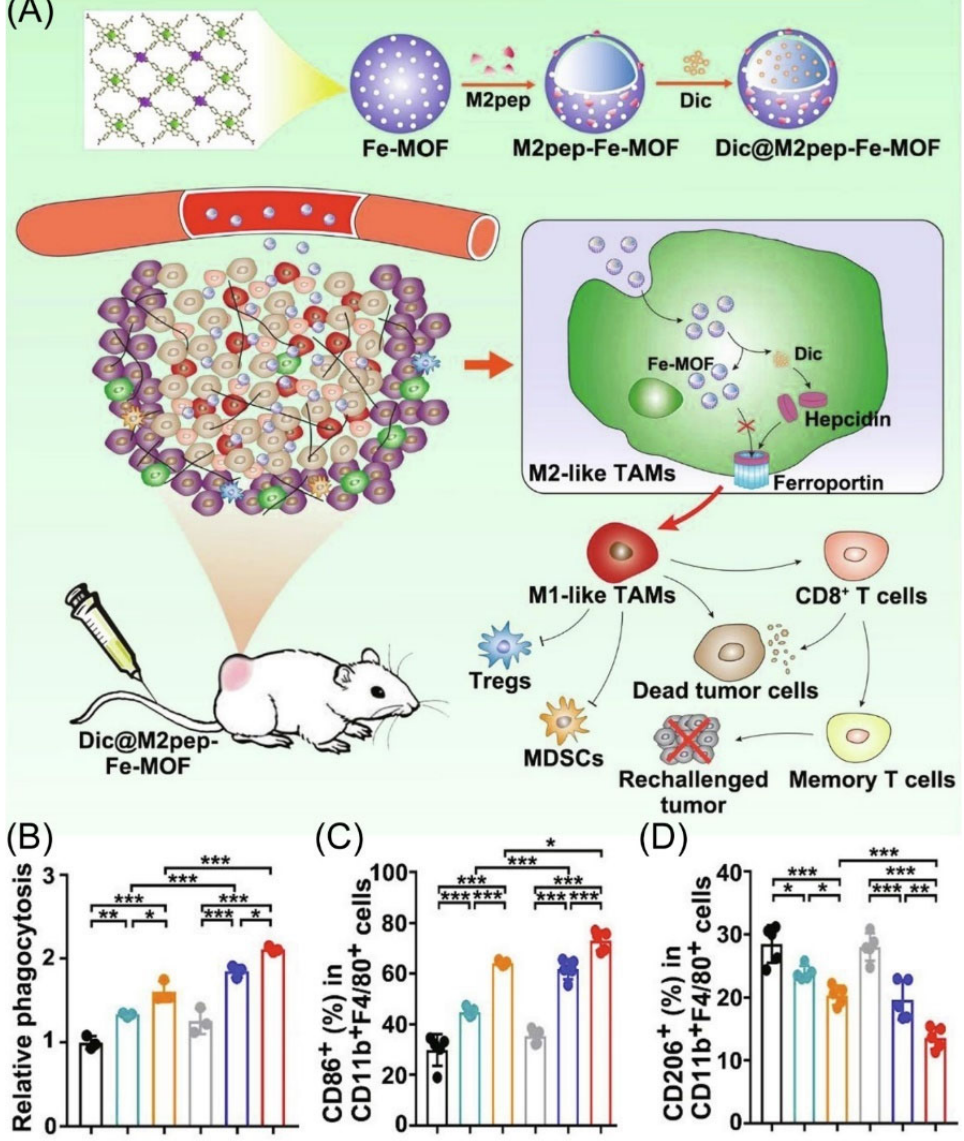
Figure 4. ( A ) Schematic diagram depicting materials to reshape the tumor immune microenvironment. ( B ) The phagocytosis ability of macrophage after different treatment co-culture under flow cytometry. ( n = 3). ( C , D ) The percentages of M1 and M2 type TAMs in tumor tissue, respectively ( n = 5). * p < 0.05, ** p < 0.01, *** p < 0.001. Copyright 2022, Elsevier [70].